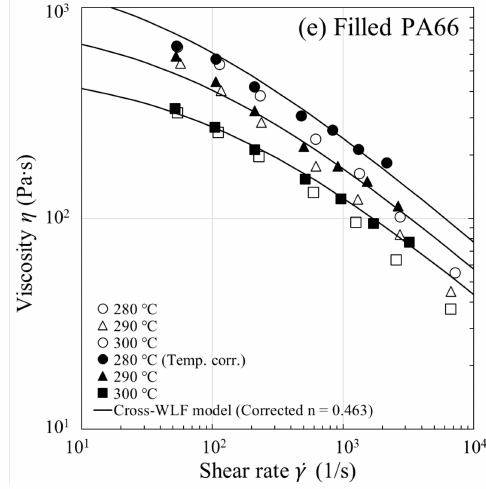
. Figure 4. Steady-state shear viscosity η ( γ ) with and without temperature correction for ( a ) HIPS, ( b ) GPPS, ( c ) ABS, ( d ) PP, and ( e ) filled PA66. The open and filled symbols represent, respectively, the uncorrected and the equivalent η ( Cross-WLF model fits based on the corrected n are shown by